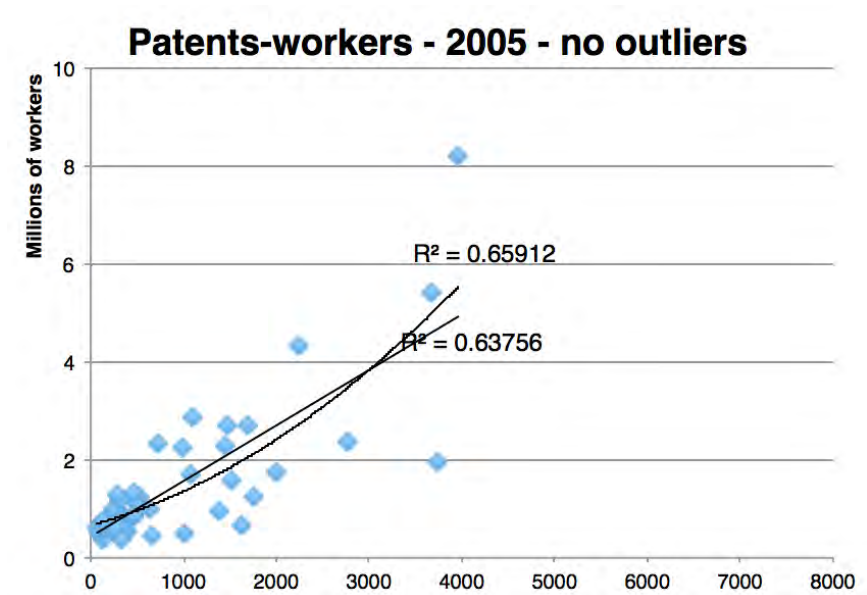
Figure 6. Linear and polynomial regression without two